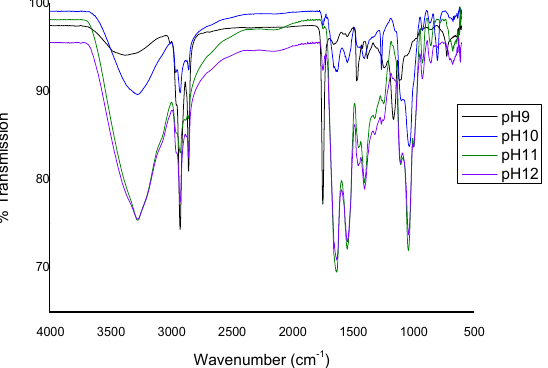
Figure 1. FTIR Spectrum of FPC edible film at pH 9, pH 10, pH 11, and pH 12.